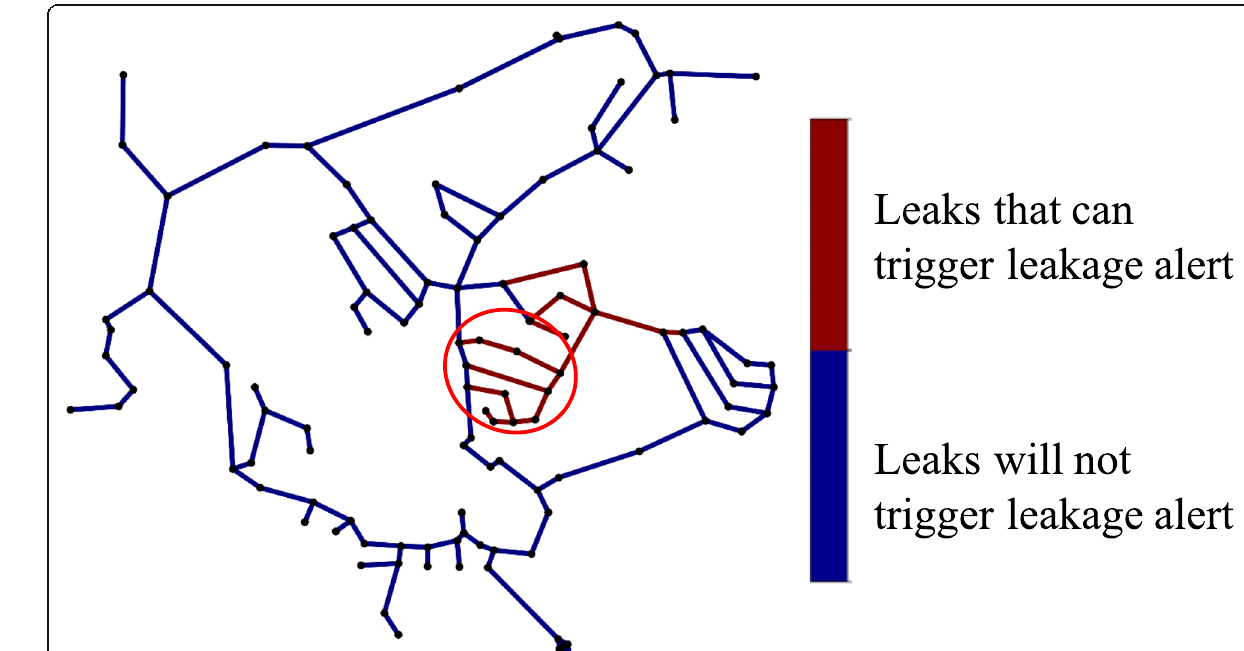
Fig. 16 Final leak detection result for each pipe leaking